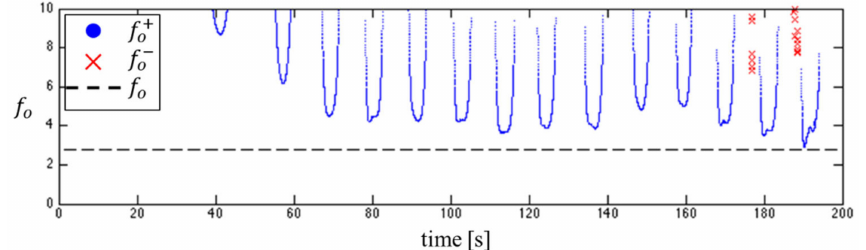
Figure 8. The time histories of the safety factors against sliding among f s + ( . ), f s − ( × ) and f s (—) for case 1.